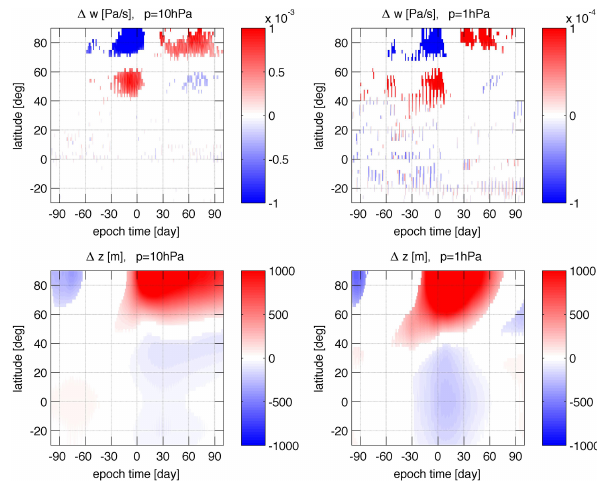
Figure 6. Composites of the anomalies (cid:49)w (positive = downward) at 10hPa (upper left) and at 1hPa (upper right). Values are only shown if they exceed the 2 σ level. Composites of the anomalies (cid:49)z at 10hPa and at 1 hPa are shown in the lower panel. A maximal, upward shift of 2900m is reached for the 1hPa geopotential height (lower